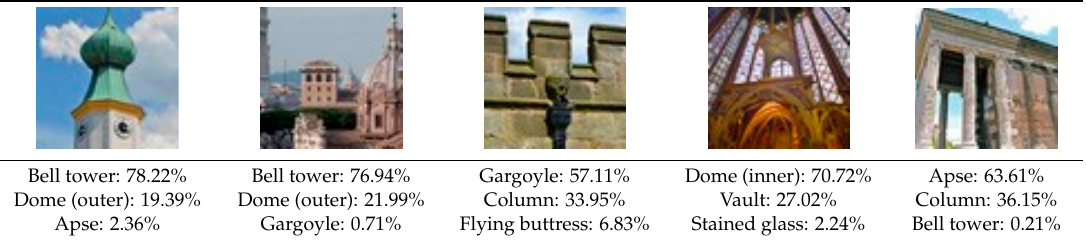
Table 11. Examples of best predictions using the ResNet network.